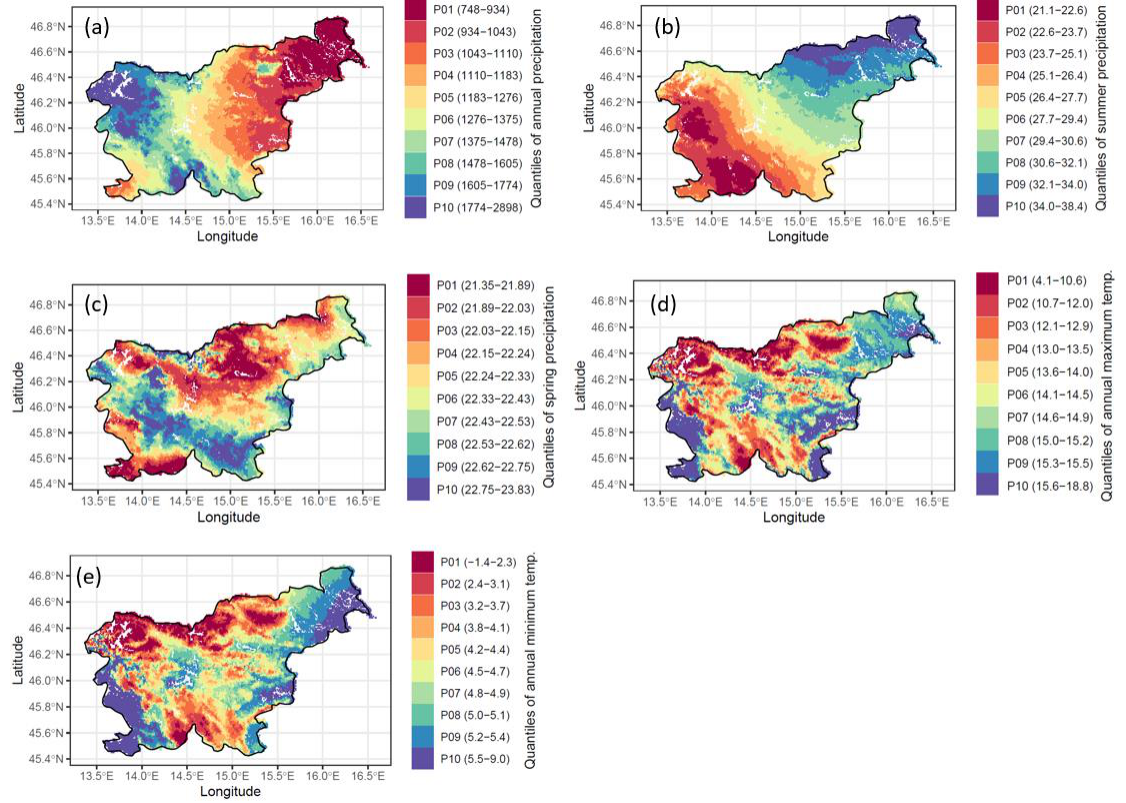
Figure 2. Climate characteristics of the forest stands in Slovenia: ( a ) mean annual precipitation [mm], ( b ) summer precipitation (%), ( c ) spring precipitation (%), ( d ) maximum temperatures (°C), ( e ) minimum temperatures (°C). Parameters of the model showing the coefficients with the estimated value (Esti- mate), standard error (Std. Error), z value, p -value (PR (>|z|)), and significance. Legend: tmax—maximum temperature, tmin minimum temperature, pcp precipitation,